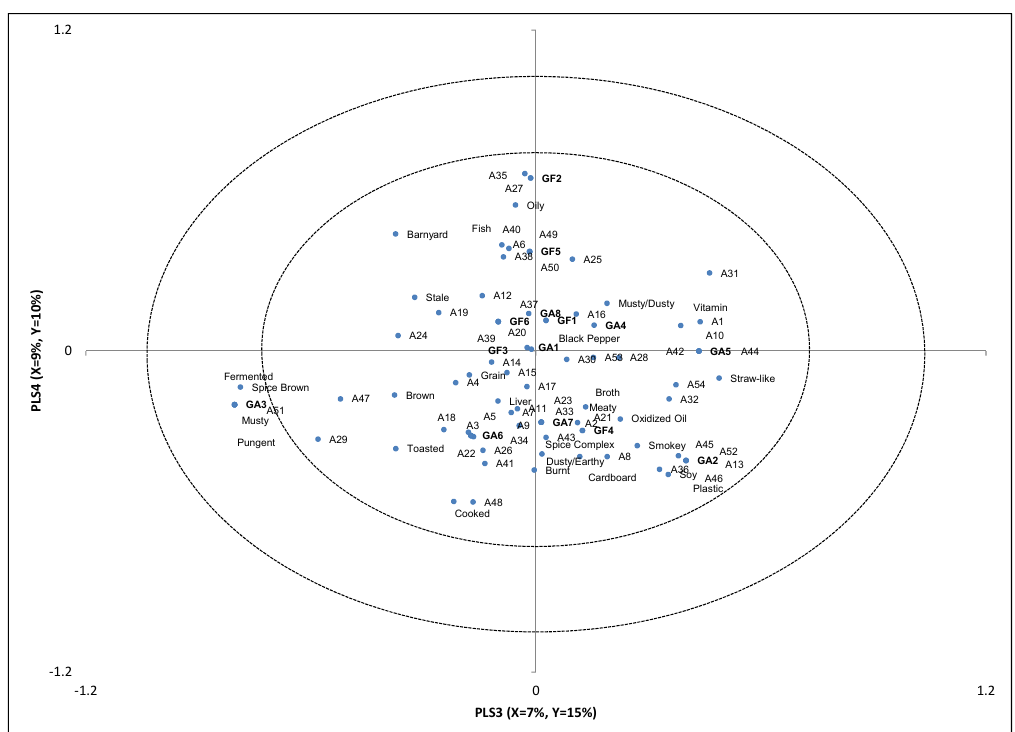
Figure 2. Partial Least Squares Regression factors 3 and